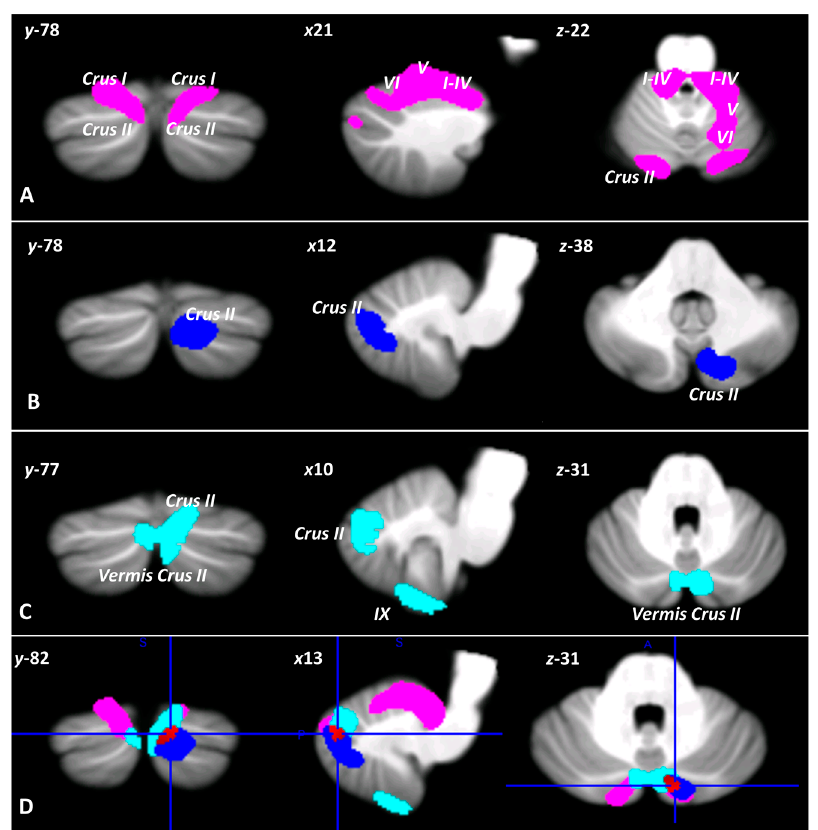
Figure 2. Voxel-wise two sample- t tests on cerebellar GM density. Cerebellar regions showing patterns of significantly reduced GM in CB ( A ), ASD ( B ), and BD2 ( C ) compared to respective control groups are reported and superimposed on the Spatially Unbiased Infratentorial Template (SUIT) [100] in coronal (y), axial (z) and sagittal (x) sections. The results were significant at p -values < 0.05 after familywise error (FWE) cluster-level correction. The region of overlapping cerebellar GM reduction in CB, ASD and BD2 is shown in red ( D ) superimposed on the SUIT. The images are presented according to neurological convention. Table 3. Two-sample t-test showing regions of cerebellar GM reduction in CB, ASD and BD2 compared to controls.